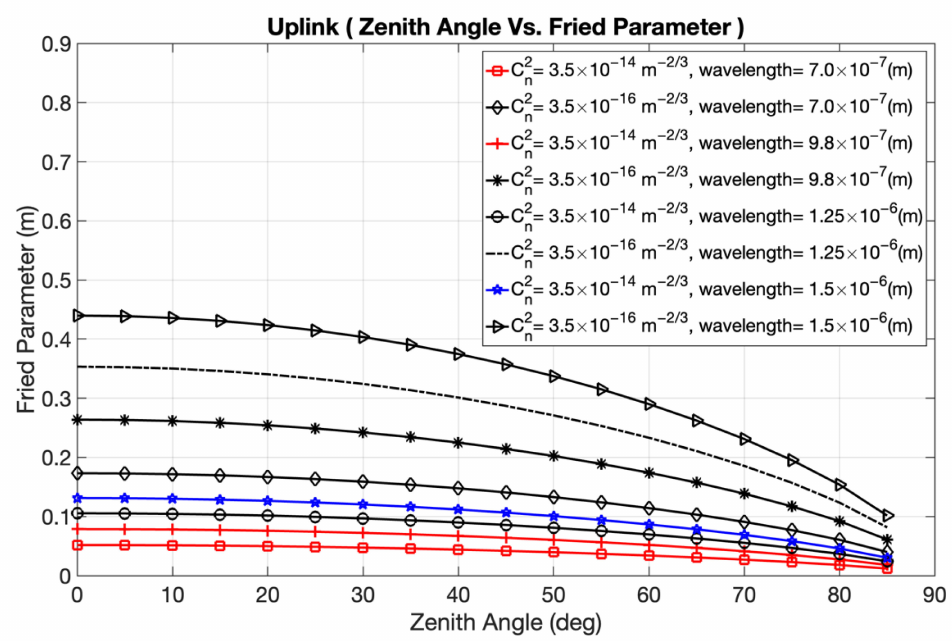
Figure 8. Variation in the Fried parameter in an uplink